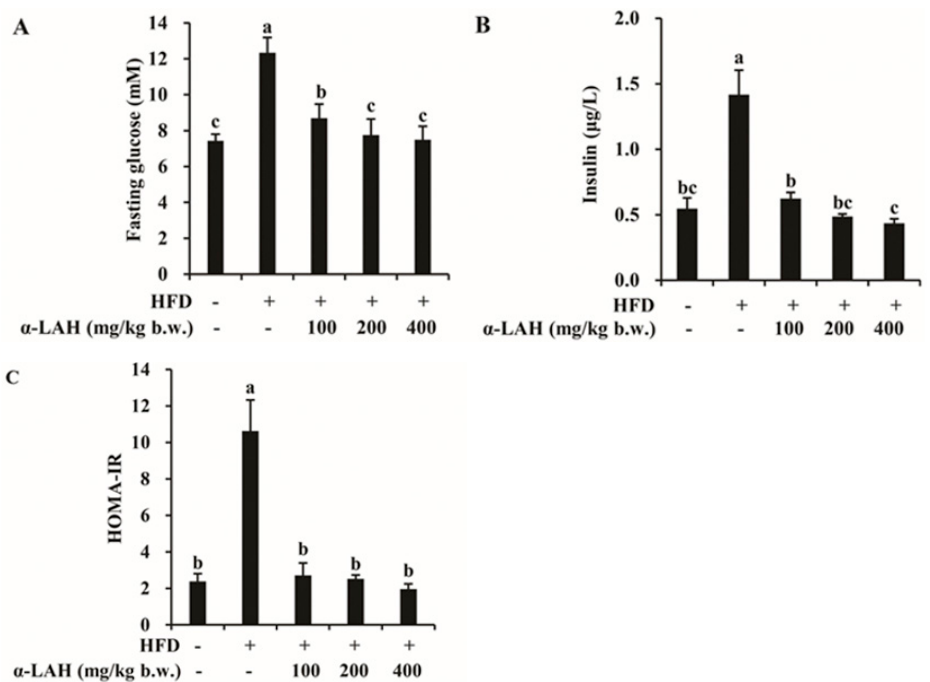
Figure 2. Effect of bovine α -lactalbumin hydrolysates ( α -LAH) supplementation on hyperglycemia and hyperinsulinemia in mice fed with high-fat diet. ( A ) Fasting blood glucose level; ( B ) fasting serum insulin level; ( C ) Homeostatic model assessment of insulin resistance (HOMA-IR) index. All data were presented as means ± standard deviations (SD) ( n = 10). Significance was determined by one-way analysis of variance (ANOVA) with the Duncan’s multiple-comparison test, and mean values without common letters indicate differences at p < 0.05.